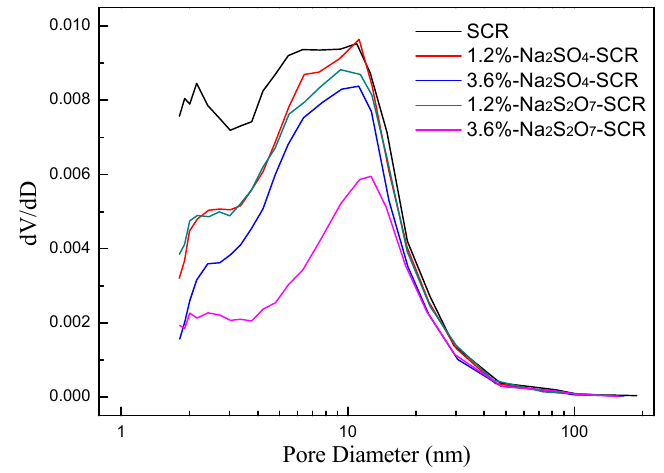
Figure 10. Barret–Joyner–Halenda (BJH) pore size distribution curves of the catalysts.